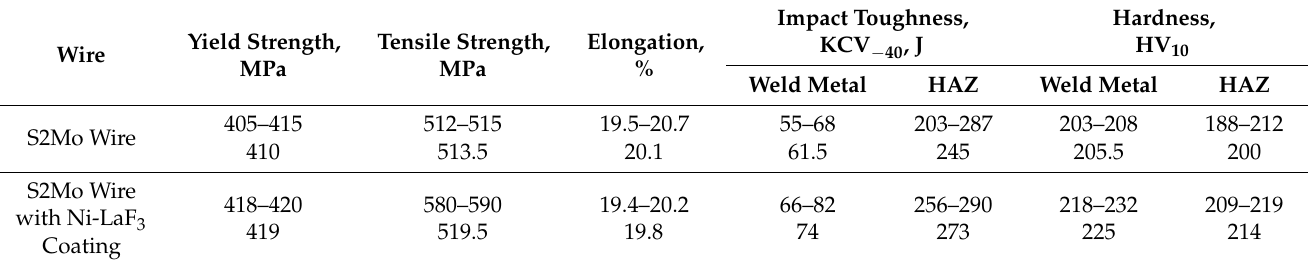
Table 6. The mechanical properties of the welds of 09G2S steel with S2Mo